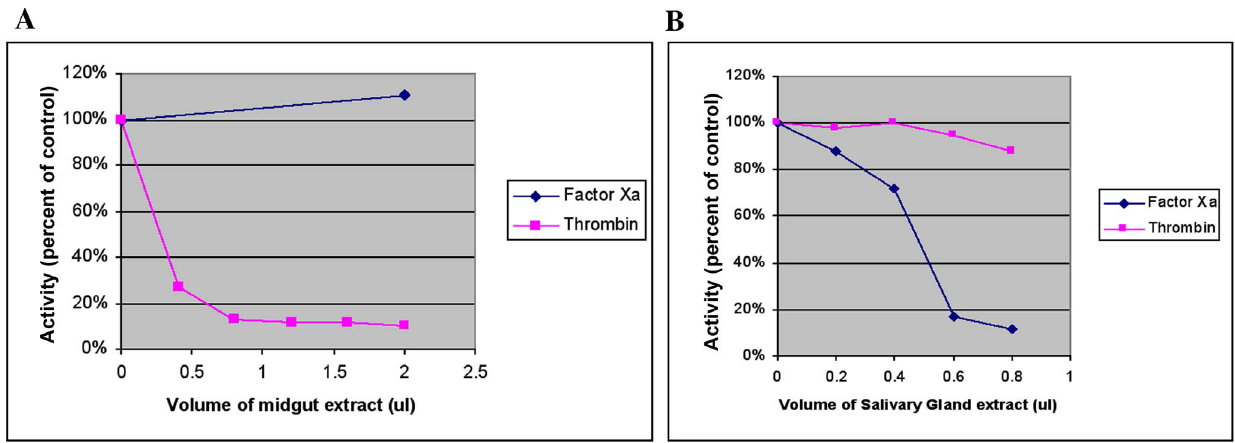
Figure 1. Ixodesscapularis gut extracts inhibit thrombin. A . Inhibition of factor Xa (solid diamonds) and thrombin (solid squares) by an extract from adult tick guts. Each gut was homogenized in approximately 30 m l of PBS. B . Inhibition of factor Xa (solid diamonds) and thrombin (solid squares) by an extract from adult tick salivary glands. Each pair of salivary glands was homogenized in approximately 30 m l of PBS.